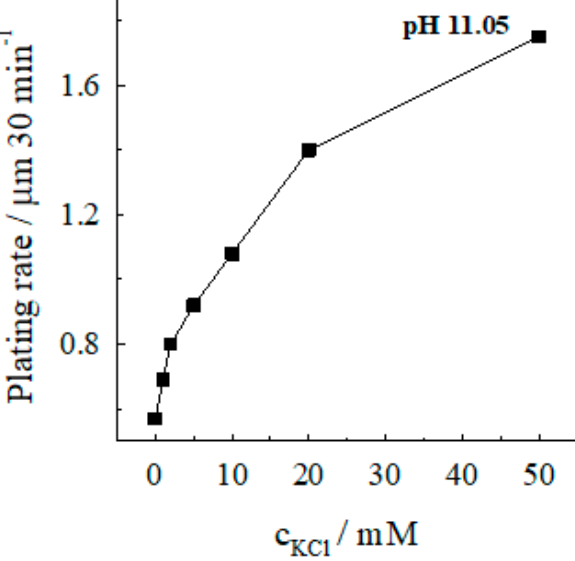
Figure 4. Dependence of the silver deposition rate on the chloride concentration. Solution composition (M): AgNO 3 —0.04, CoSO 4 —0.10; (NH 3 + NH 4+ )—7; pH 11.05; 20 °C.